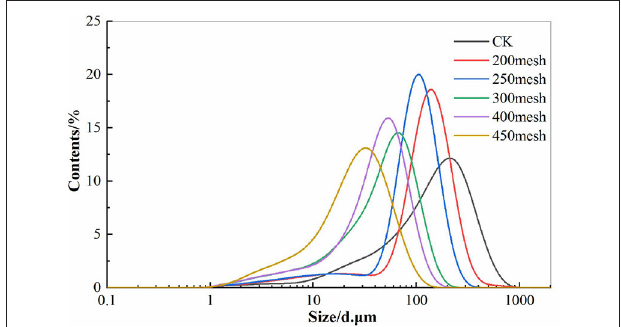
FIGURE 1 | Particle size distribution of IDF from corn bran. CK: IDF from corn bran (about 60 mesh), the rest of the samples were crushed by ultrafine pulverizer and sieved with different mesh sieves from 200 to 400 mesh, Subsequent test samples were processed according to this